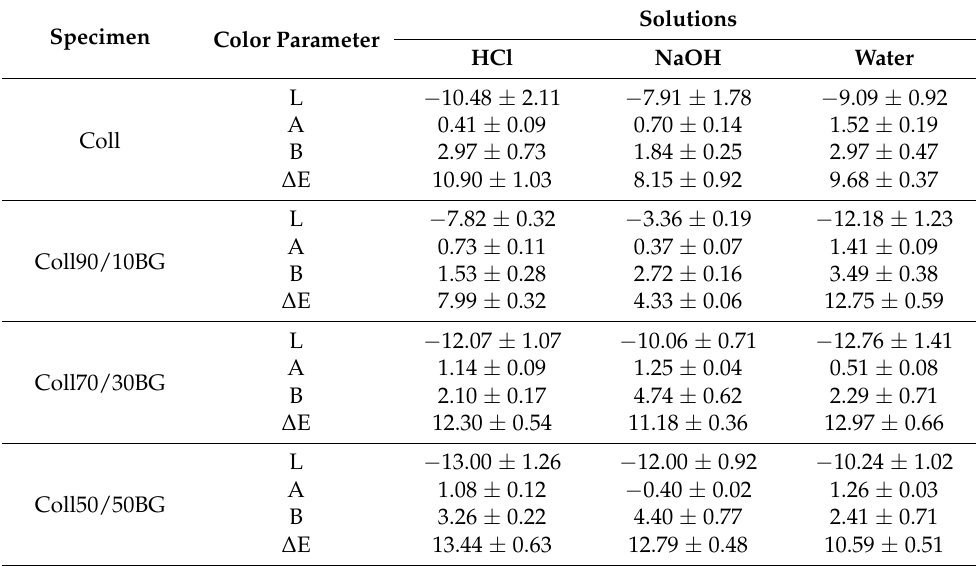
Table 6. Color parameters (L—lightness, a—red (+) to green ( − ), b—yellow (+) to blue ( − b), and ∆ E—total color difference) of the